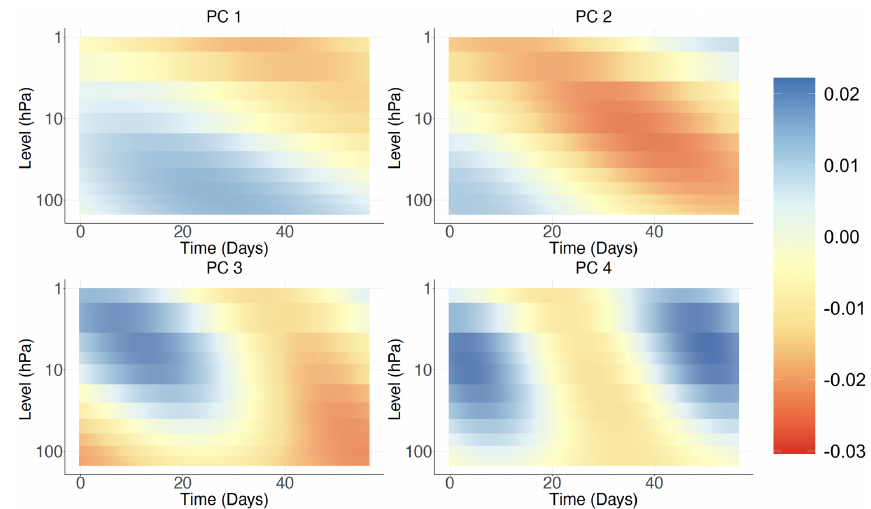
Figure 3. First four principal directions corresponding to the largest variance obtained from PCA on polar-cap-averaged temperature anoma- lies at levels 150, 125, 100, 70, 50, 30, 20, 10, 7, 5, 2, and 1hPa, indicated by the different colors in the legend, with a temporal embedding of T = 2 months. Each PC explains 33%, 24%, 10%, and 7% of the overall variance, respectively.